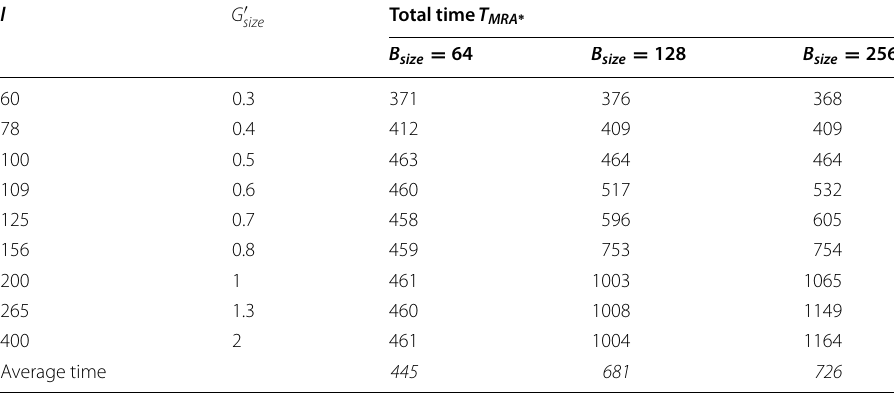
Table 4 Impact of blocks size and subgraphs length on the computational time in seconds l G ′